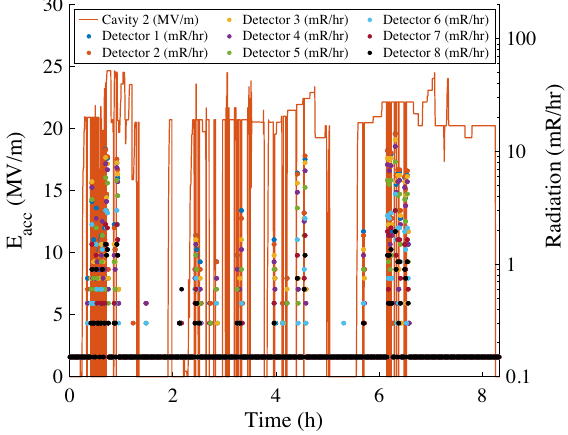
FIG. 10. Example of sporadic quenching over a long duration of operation at elevated gradient. A ∼ 1 hr pause in testing cavity 2 (during which other cavities were tested) is removed from the plot for ease of visualization.